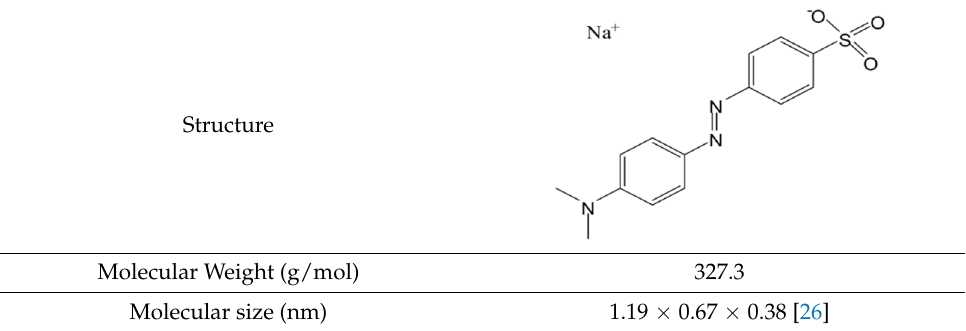
Table 2. Chemical structure and characteristics of MO.